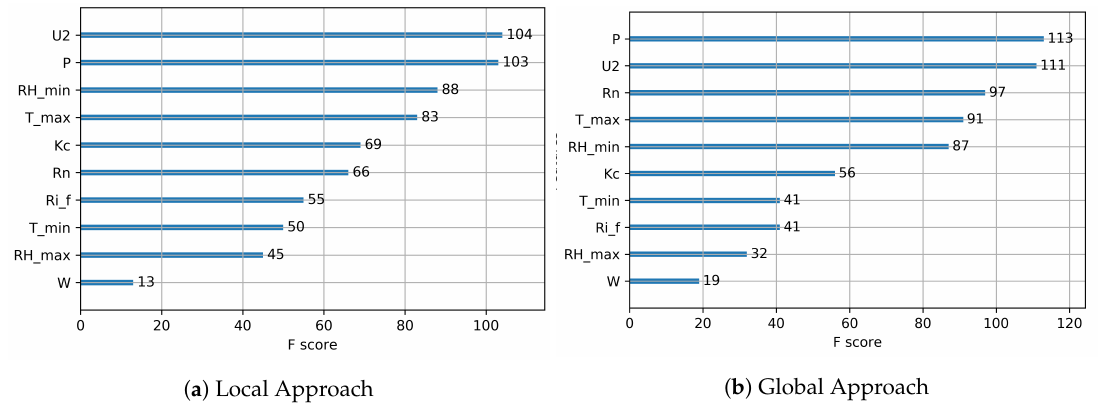
Figure 7. Analysis of the relevance of features by gradient boosting prediction approach.